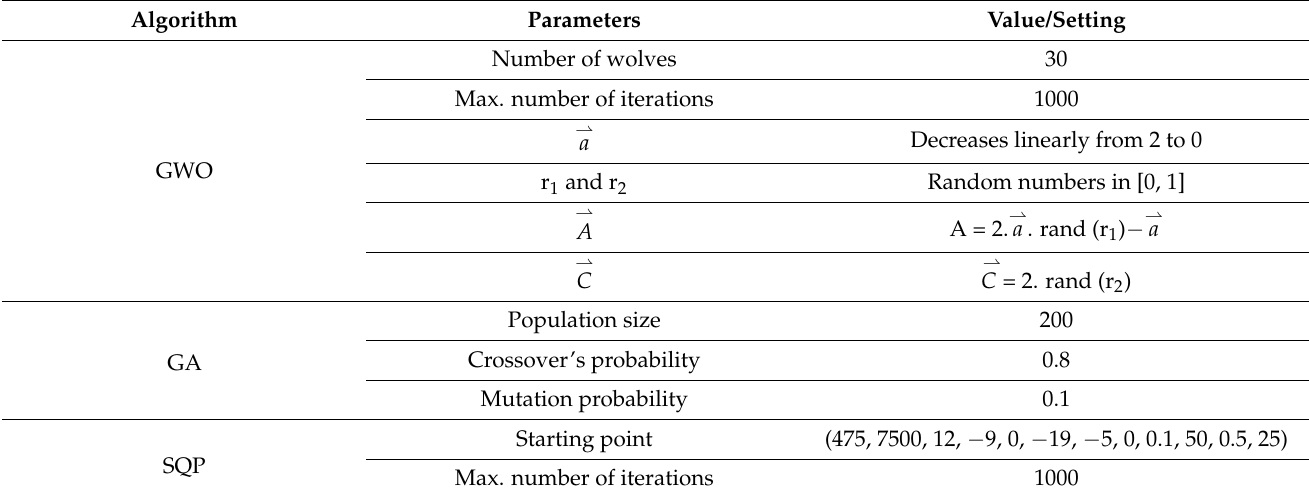
Table 1. The set parameters of the employed